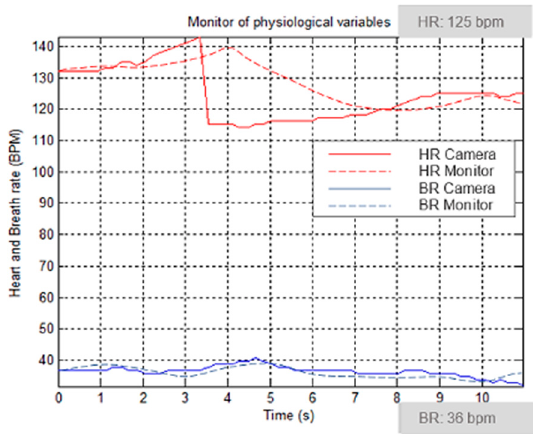
Figure 10. Signal Monitor development in Matlab vs. NICU monitor.